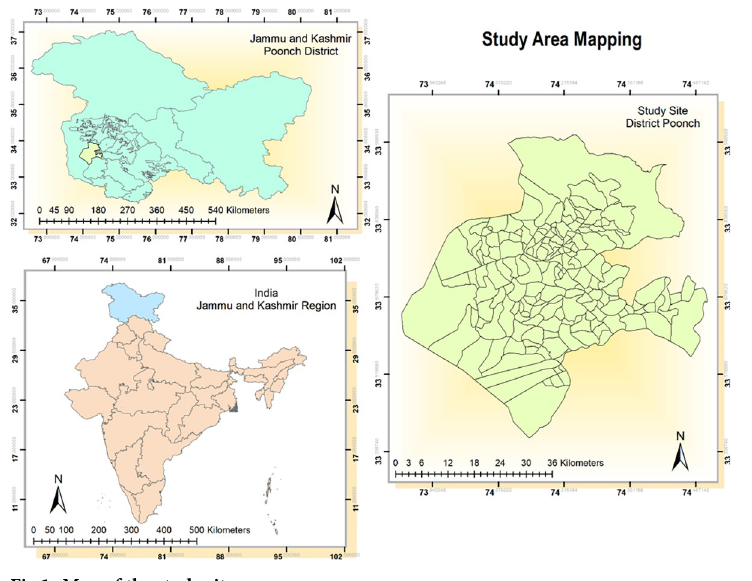
Fig 1. Map of the study